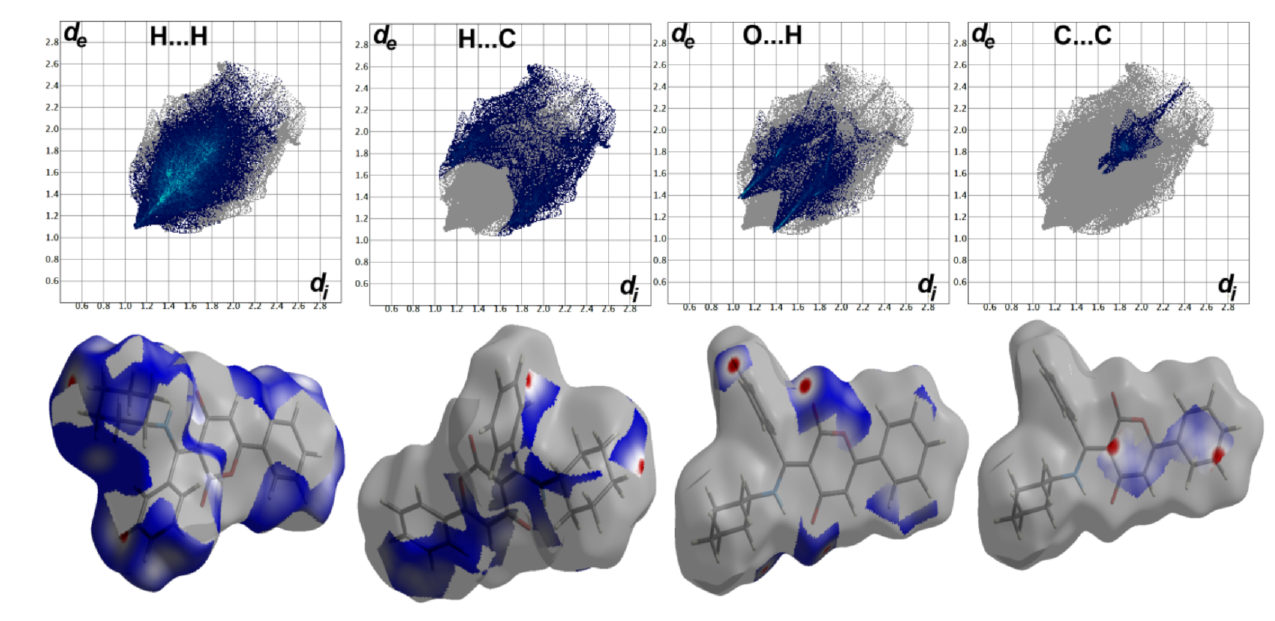
Figure 9. Decomposed fingerprint plots and d norm Hirshfeld surfaces of the most abundant interactions in 4 . In case of compound 5 , there are two different molecules per asymmetric unit hence the Hirshfeld surface and fingerprint plots shown in Figure 10 are presented for the two molecular units in the crystal. The contacts in both molecules are common in both